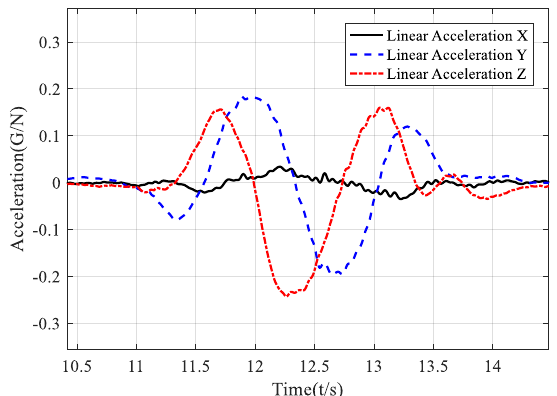
Figure 1. Time domain diagram of acceleration in the local earth coordinates.